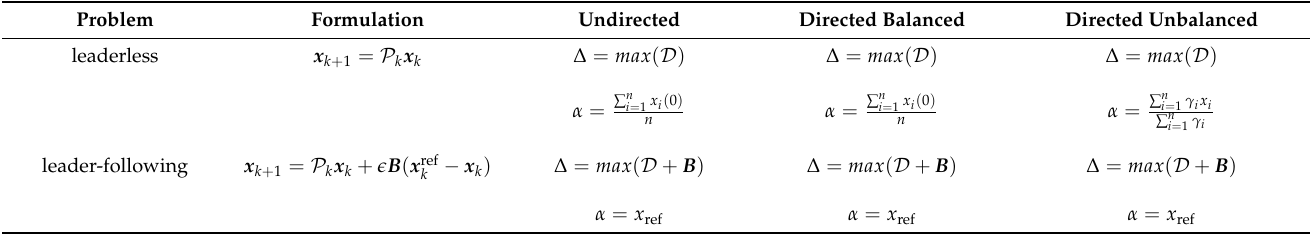
Table 4. Summary of the leaderless and leader-following consensus formulations in discrete-time.